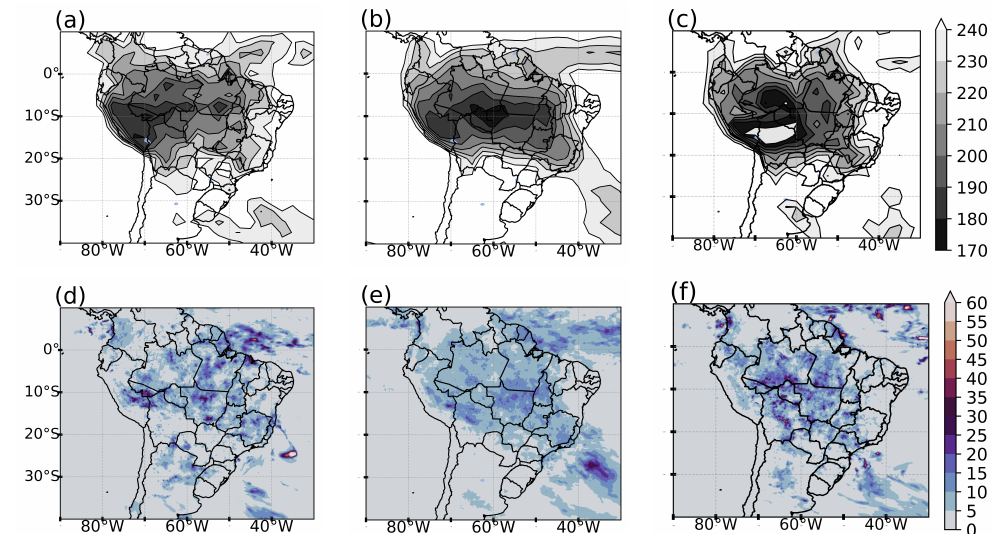
Figure 5. Composites of the OLR (W · m − 2 ) ( a – c ) and precipitation (mm · day − 1 ) ( d – f ) for the − 3D (left), 0D (center), and +2D (right) panels of the SACZ events during the unfavorable phase of the